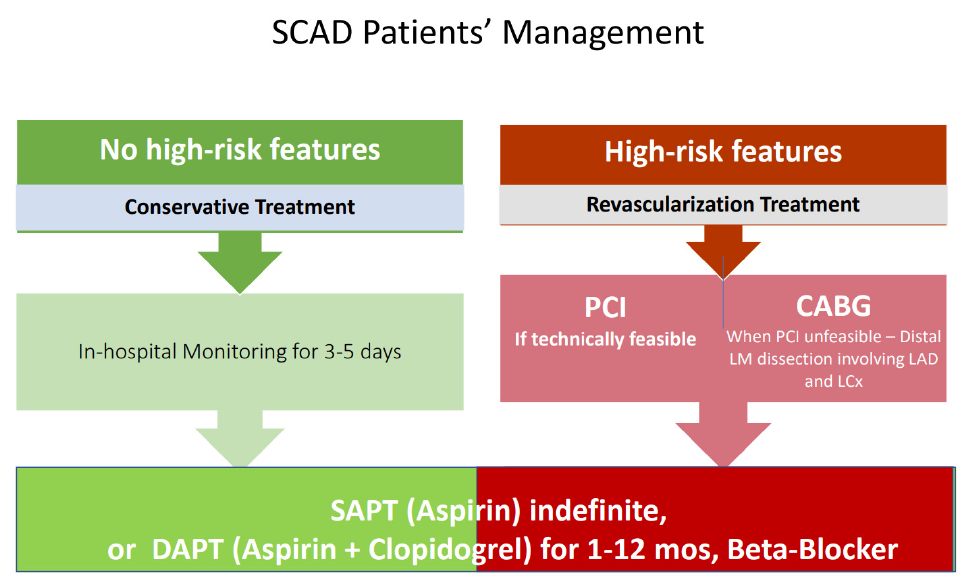
Figure 2. SCAD Treatment Algorythm. Figure legend: PCI: Percutaneous Coronary Intervention; CABG: Coronary Artery Bypass-Graft; SAPT: Single Antiplatelet Therapy; DAPT: Dual Antiplatelet Therapy.